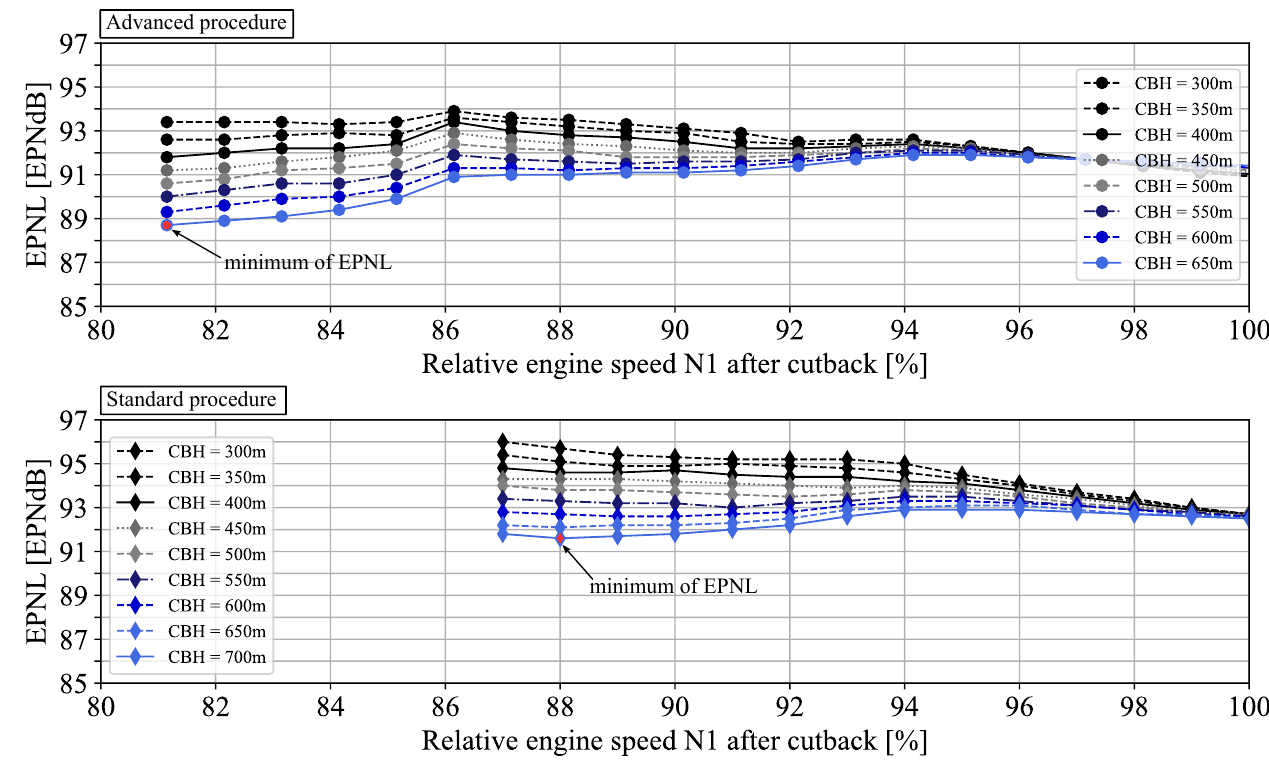
Figure 5. EPNL at flyover measurement point over relative engine speed N1 after pilot-initiated cutback of flightpath variation for advanced ( top ) and standard departure procedure ( bottom ) in the allowed range of certification regulations in terms of cutback height (CBH) ( ≥ 300 m) and climb rate ( ≥ 4%) for the aircraft TWO